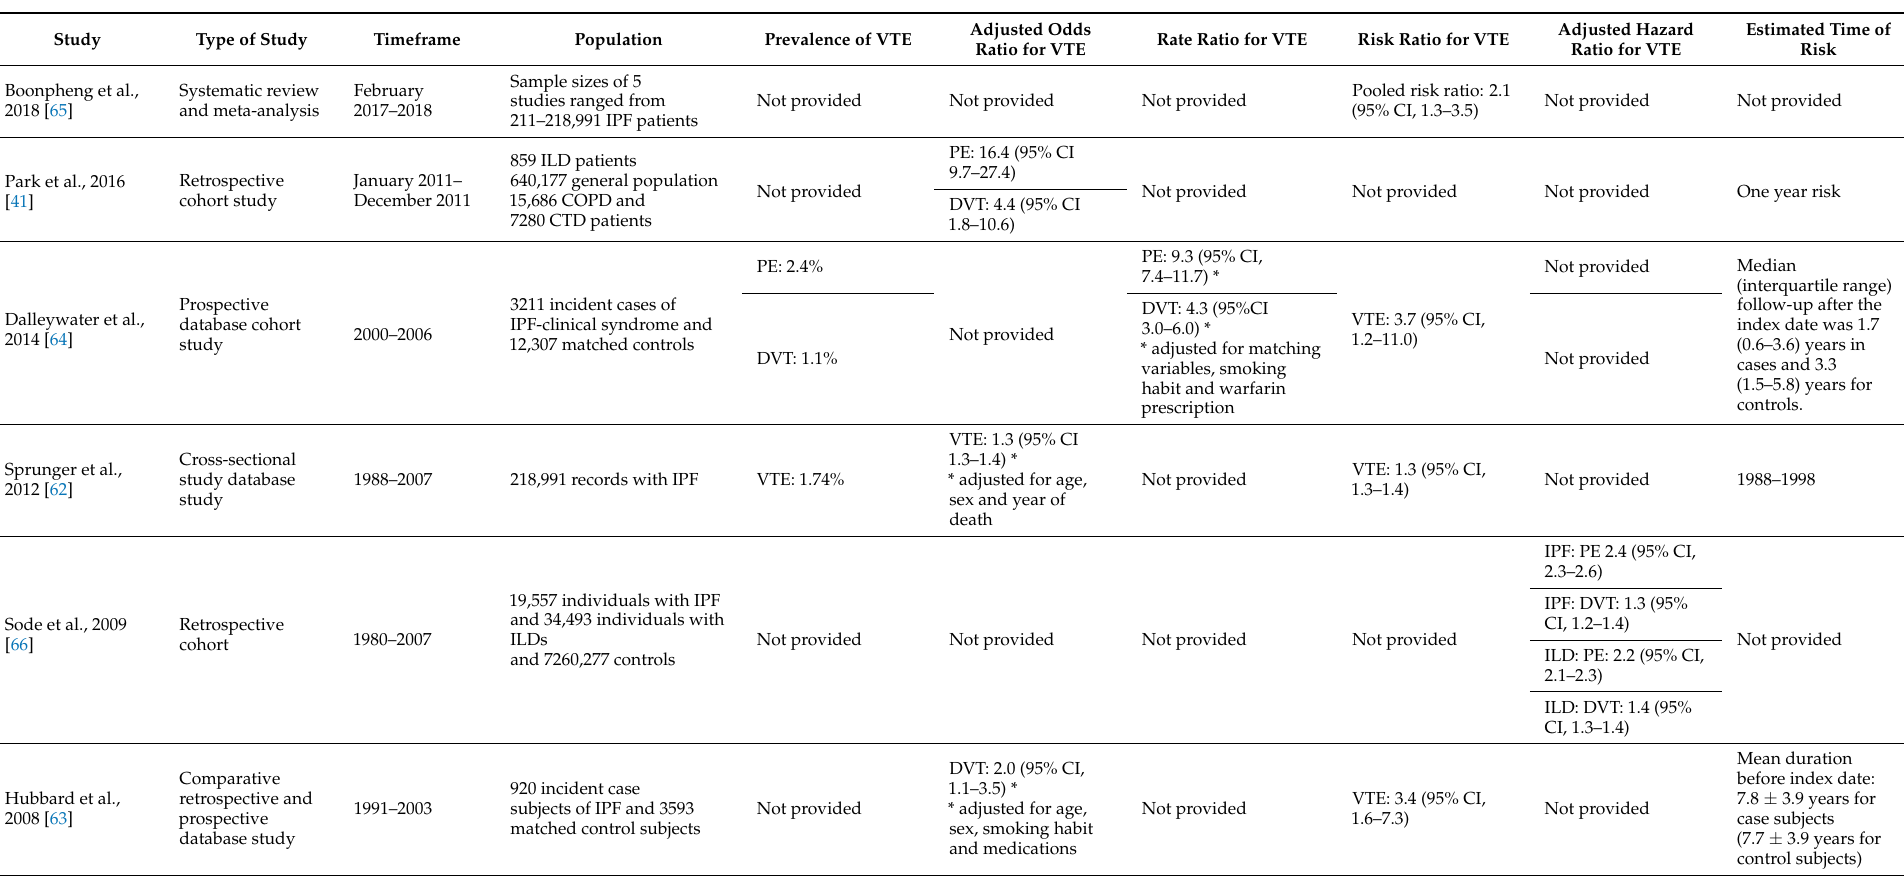
Table 3. Characteristics of studies included in this review regarding the relationship between interstitial lung diseases (ILDs) and venous thromboembolic disease